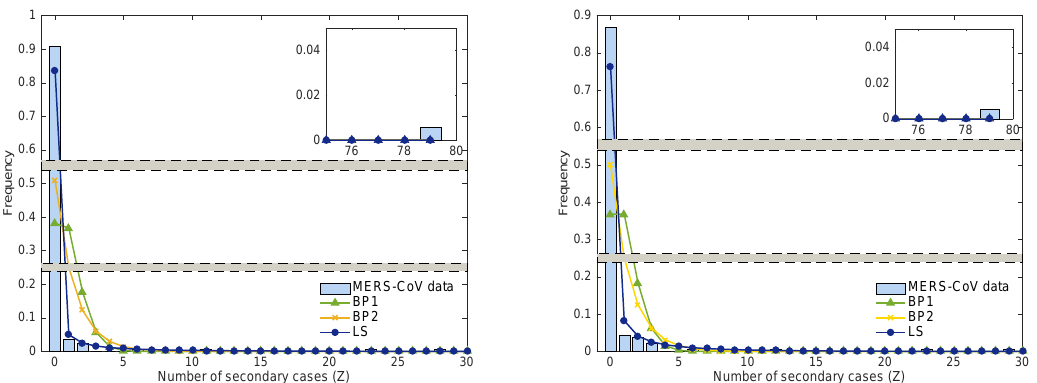
Figure 5. The distributions of secondary cases for the three models are compared with the MERS-CoV data; the left panel with k = 0.063 and R 0 = 0.96 and the right panel with k = 0.12 and R 0 =